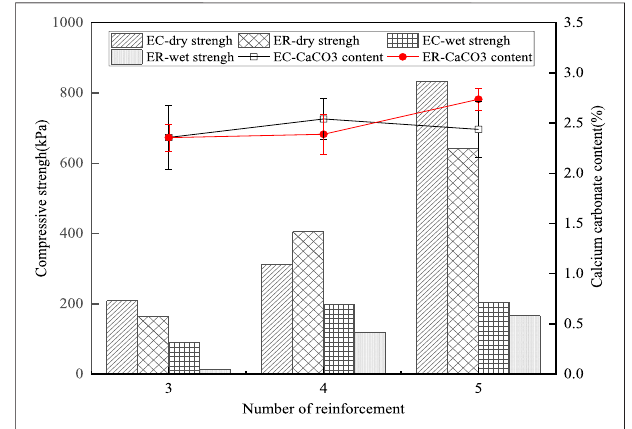
Frontiers in Physics |